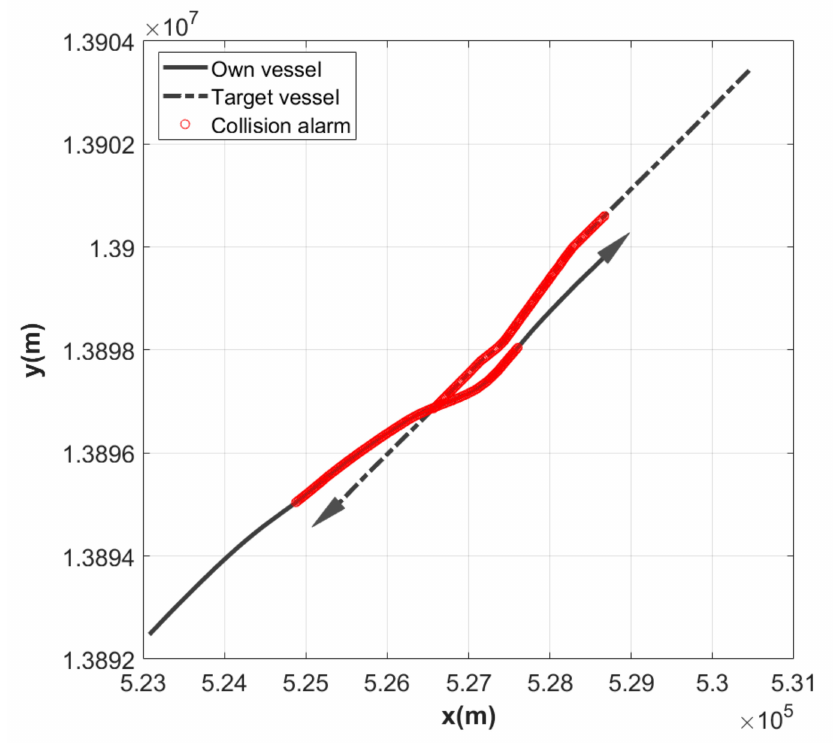
Figure 6. Trajectories of encountering vessels in the case of head-on situation.